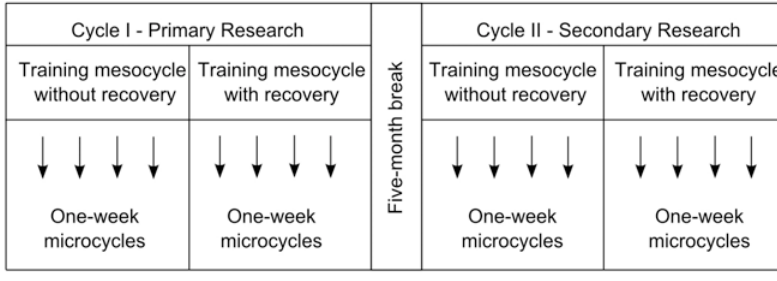
Figure 1. Diagram of the study schedule. Table 1. Evaluation of means of blood pressure and heart rate in selected days of training during Cycle I and II – first meso-cycle without athletic recovery – variance analysis and LSD.